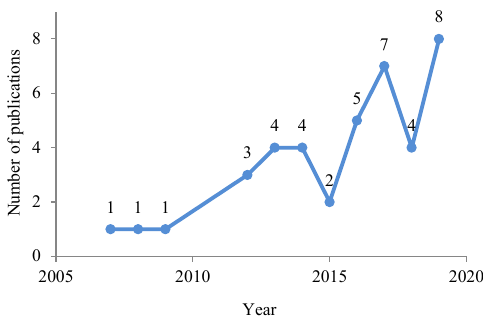
Figure 1 Time distribution of the 40 papers